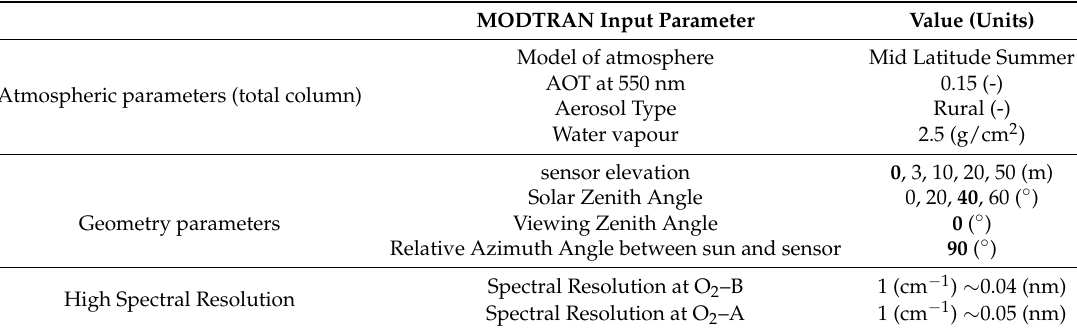
Table A1. MODTRAN input parameters used to generate data from Section 2.1. MODTRAN Mid Latitude Summer (MLS) atmospheric model was selected for the sake of compatibility with numerous SIF field campaign measurements taken over Europe and United States during the spring and summer seasons. MODTRAN radiance with scattering mode was used to compute the total solar irradiance at different elevations. Solar irradiance at different elevations was computed by changing the surface elevation parameter. Total solar irradiance reaching the surface, accounting the direct and diffuse contribution, was computed by following the MODTRAN interrogation technique described in [60] and assuming a perfect reference panel having a Lambertian surface reflectance of ρ = 1. Simulations were performed using the correlated-K slow option with DISORT (8 streams) selected and the multiple scattering option IMULT activated. Highlighted geometry parameters in bold are used in simulations performed in Section 4.